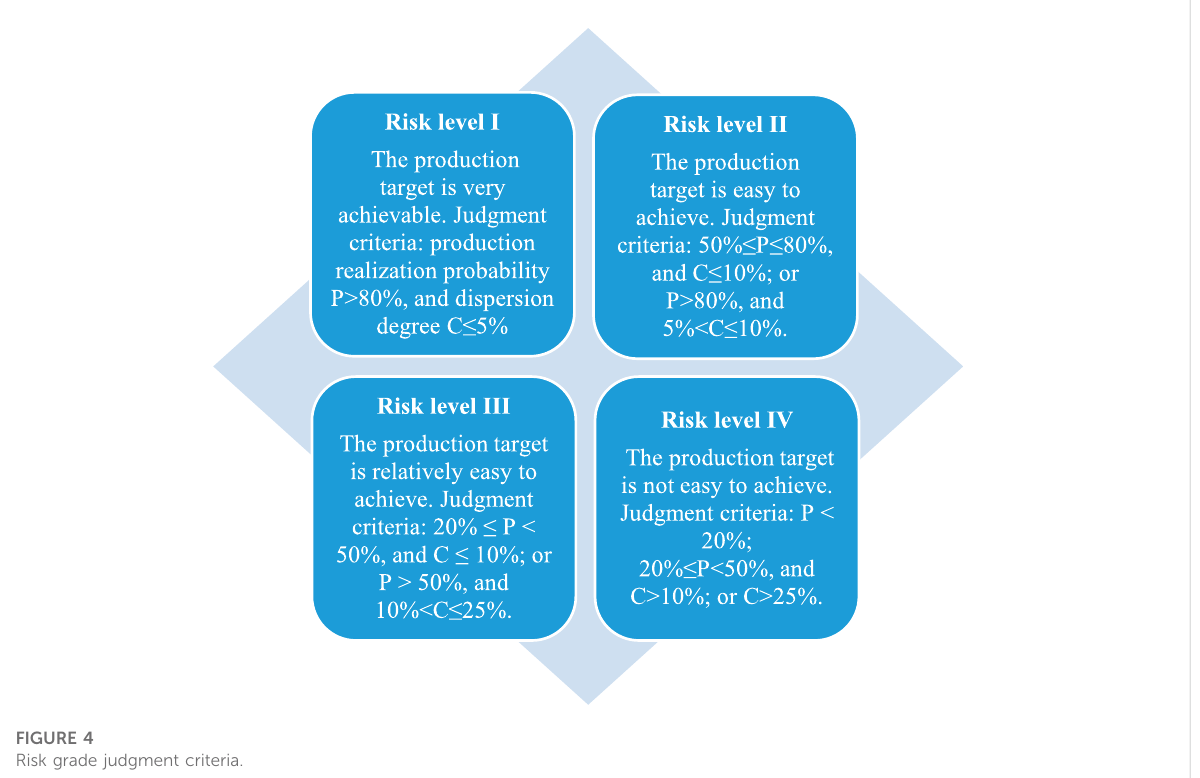
FIGURE 4 Risk grade judgment criteria.